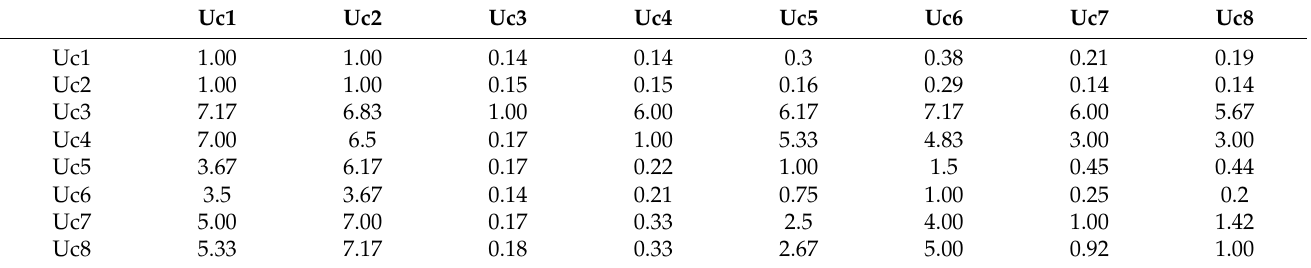
Table 3. Matrix for the pairwise comparison of the adaptive evaluation criteria using the arithmetic means of the values assigned by evaluators.